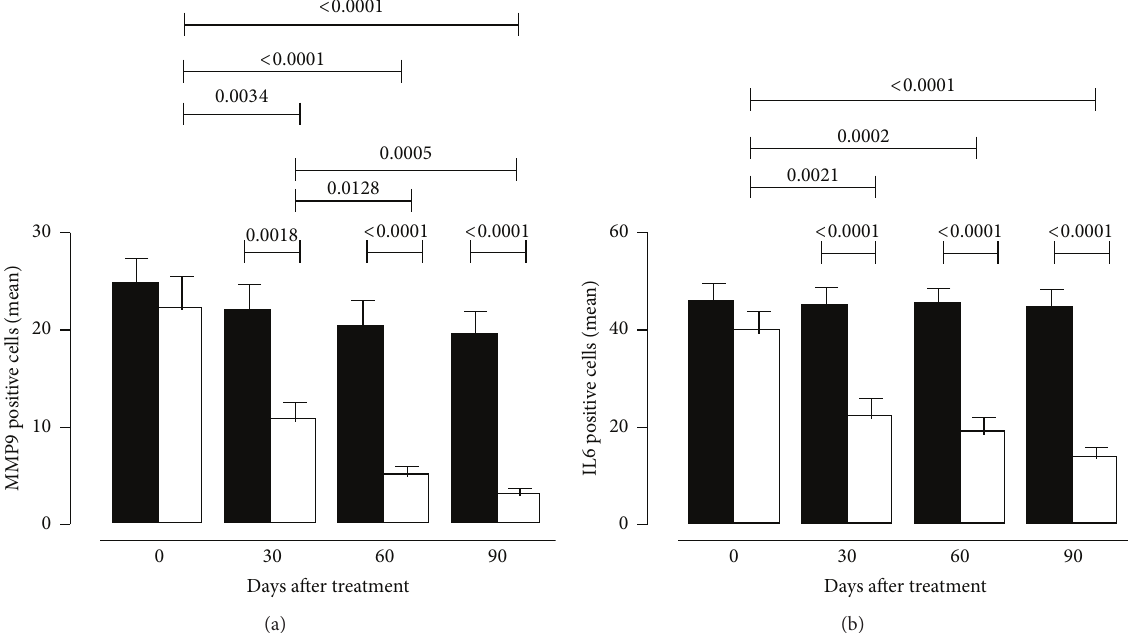
Figure 4: Statistical analysis of MMP9 (a) and IL6 (b) expression in Hylogel (black bars) and Optive (white bars) groups at baseline (day 0) and its variations during follow-up period (30, 60, and 90 days). Data are expressed as mean ± SEM. The unpaired Student’s 𝑡 -test was used to evaluate differences in markers expression. Significant 𝑝 values are